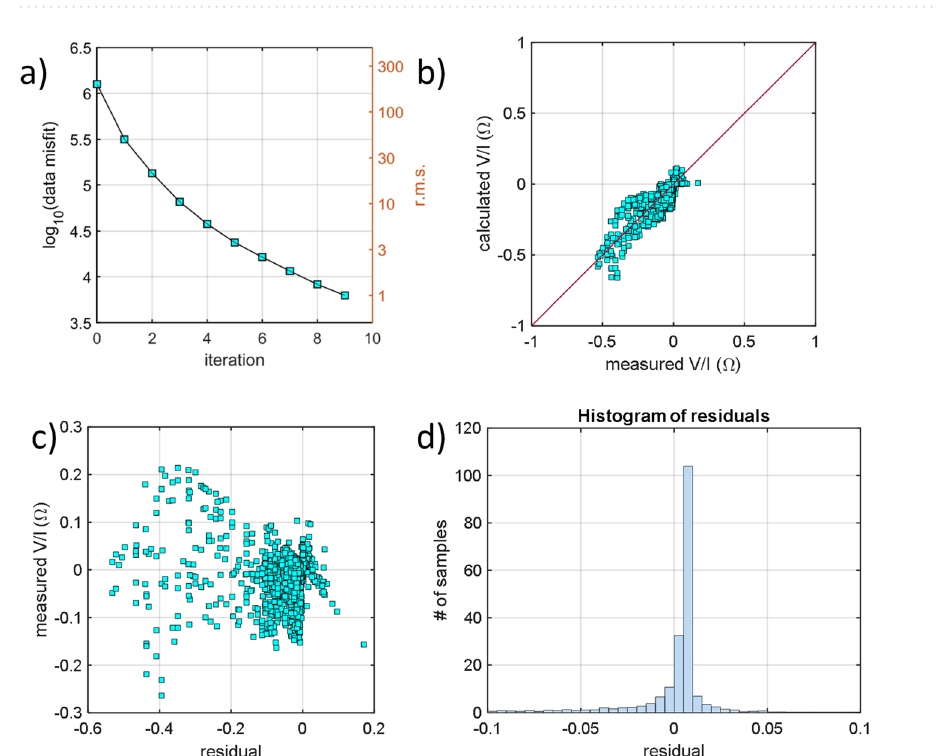
Figure 12. ( a ) Common logarithm of the data misfit plotted as a function of the number of inversion iterations. ( b ) Transfer resistances [Ω] calculated by the 3D inversion plotted as a function of the measured transfer resistances [Ω]. ( c ) Measured transfer resistances [Ω] plotted as a function of the residuals. ( d ) Histogram plot of the misfits. The figure was created using the MATLAB R2020b commercial software (https:// www. mathw orks. com/ produ cts/ MATLAB.